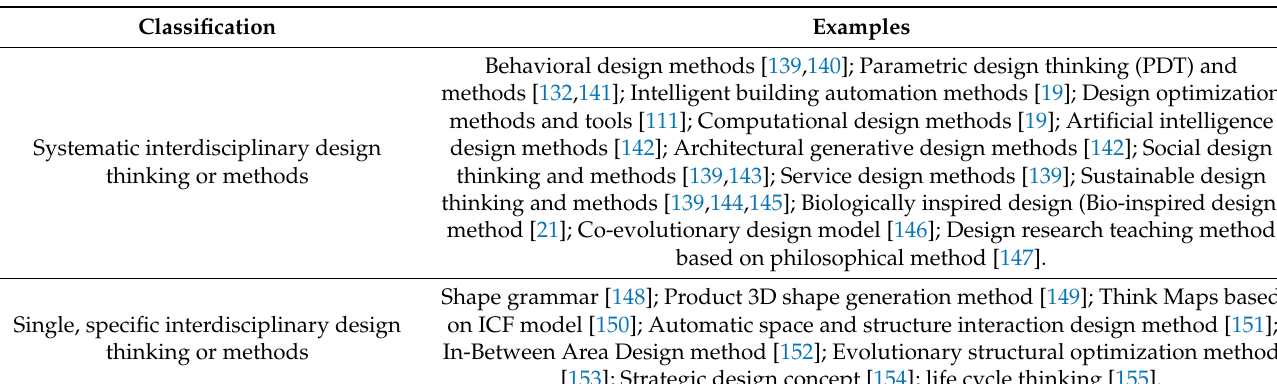
Table 2. Examples of interdisciplinary design thinking or